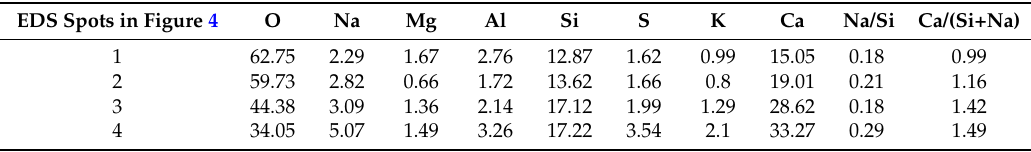
Figure 4. Fracture morphology of mortar at 28 days. ( a ) normal curing; ( b ) 80 °C steam curing; ( c , d ) microwave curing. Table 1. Element composition of calcium silicate hydrate.